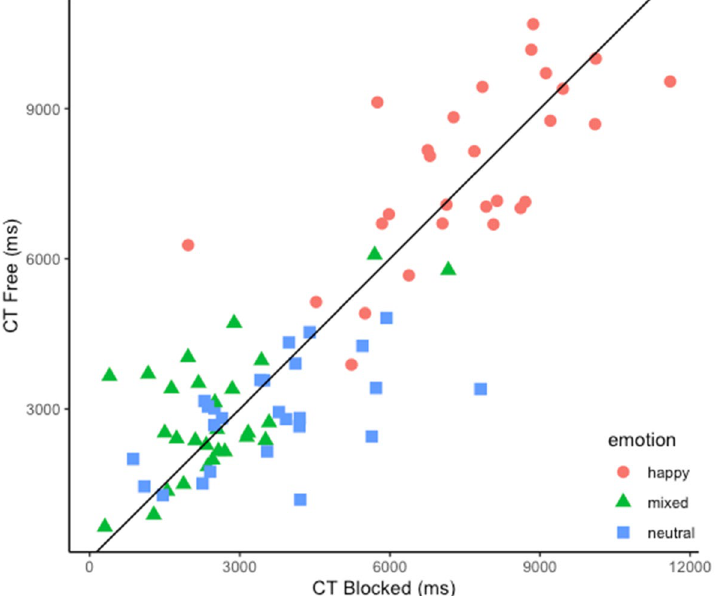
Figure 3. Each point represents a participant’s cumulative time (CT) for a specific emotion. Mimicry condition is projected on the x and y axes, the black line represents the axes equidistance. The CT is expressed in